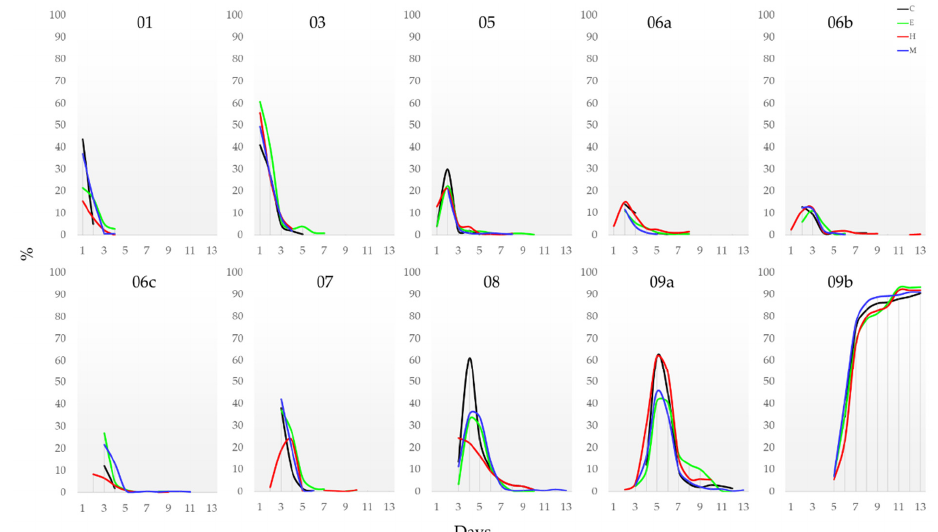
Figure 2. Percentage of basil seeds germination stage according to BBCH scale for growth and development with all secondary stages: 00—dry/innactive seed, 01—beginning of seed imbibition, 03—seed imbibition complete, 05—radicle emerged from seed, 06a—radicle elongation, no root hair, 06b—radicle elongation with root hair present, 06c—radicle elongation further the root hair zone, 07—hypocotil with cotyledons, 08—hypocotil with cotyledons outside seed coat, 09a— emergence, folded cotyledons, 09b—emergence, unfolded cotyledons. C—control; E— electropriming; H—hydropriming;